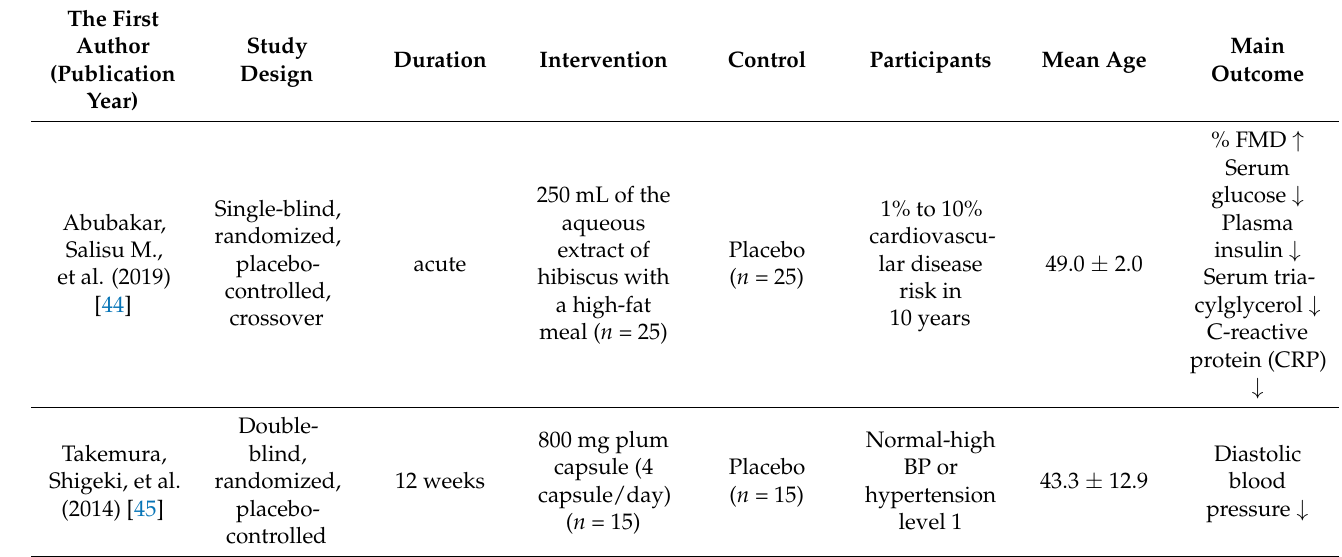
Table 5. Biological activities of other red-colored food-derived